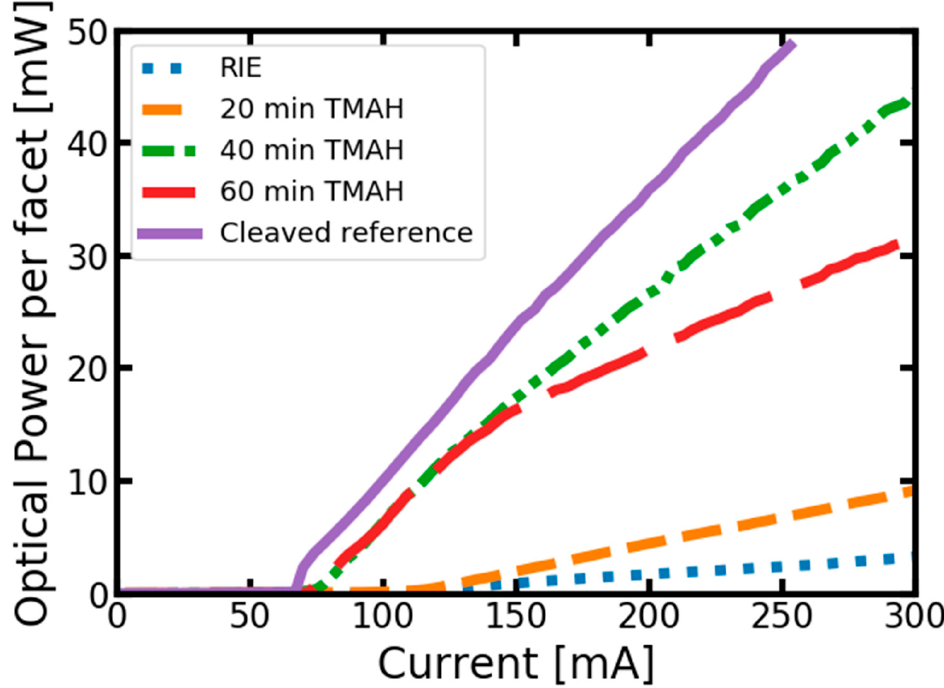
Figure 6. Light current characteristic of differently processed laser diodes (pulse current measure- ments).